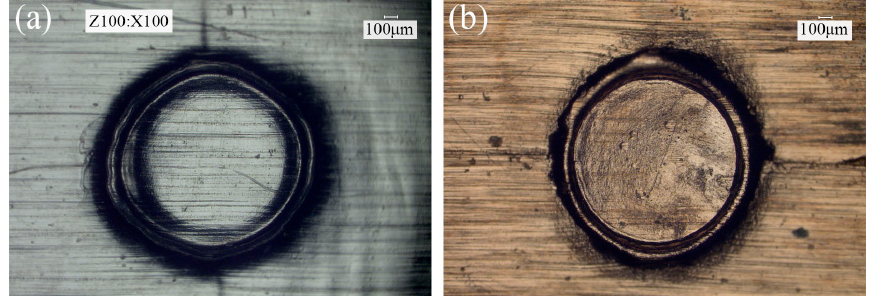
Figure 12. Surface morphology of the joint (Al/Cu: 80/20 μ m; En = 1290 mJ; 3 laser pulses; h = 70 μ m): ( a ) upper surface of the joint; ( b ) bottom surface of the joint.